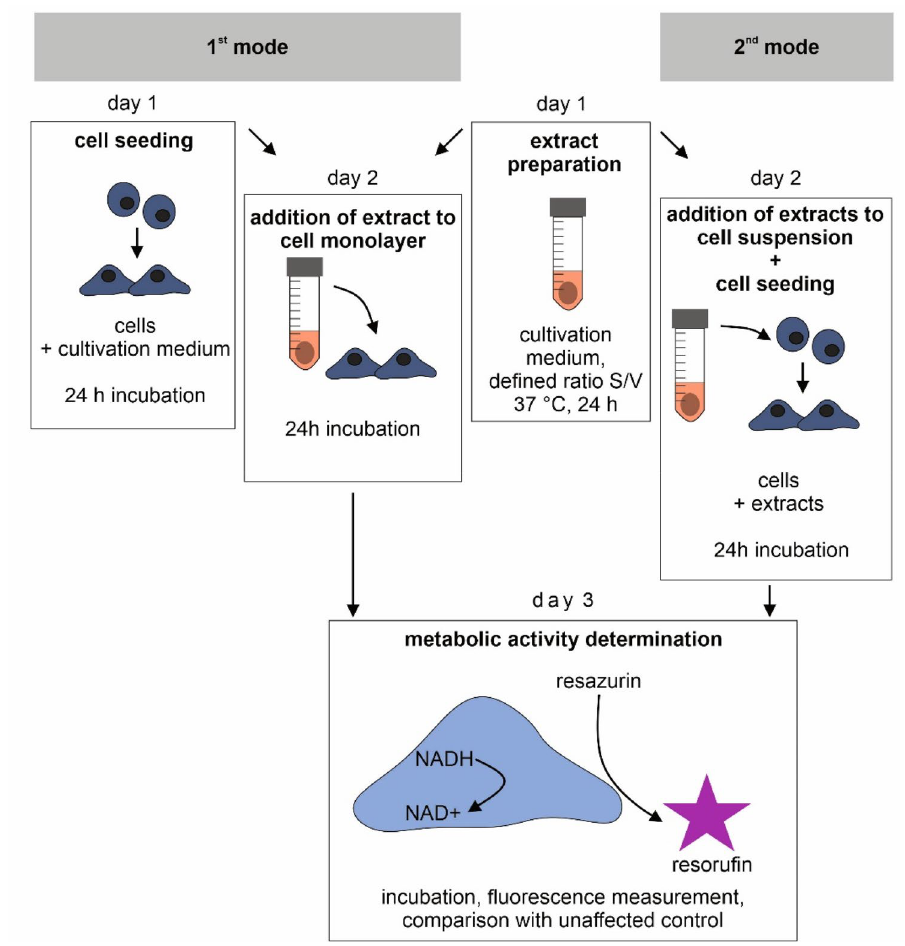
Figure 1. Two modes of exposition. Extracts were either added to a sub-confluent cell monolayer 24 h post-seeding (1st mode) or were added to freshly suspended cells (2nd mode). The figure was created using CorelDRAW 2019, version